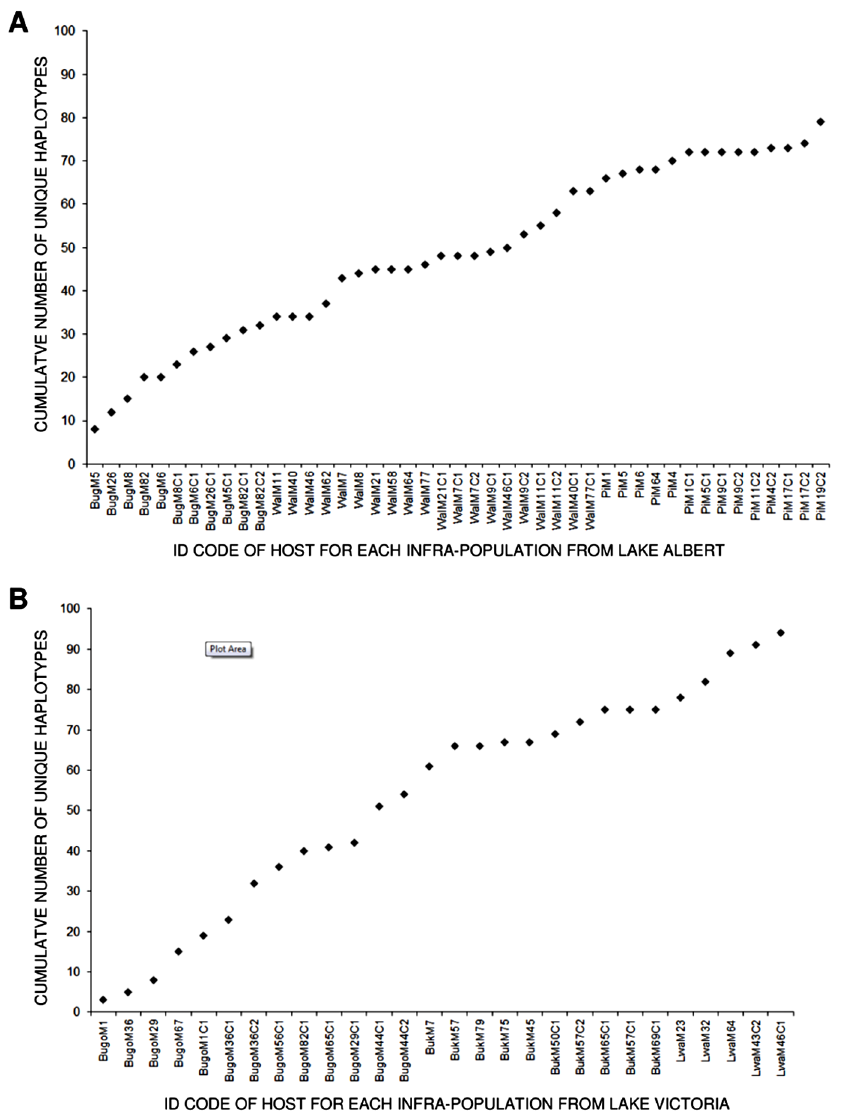
Figure 2. Cumulative number of unique haplotypes identified at baseline plotted against the identification code of each sequentially sampled host from Lake Albert (A) and Lake Victoria (B).